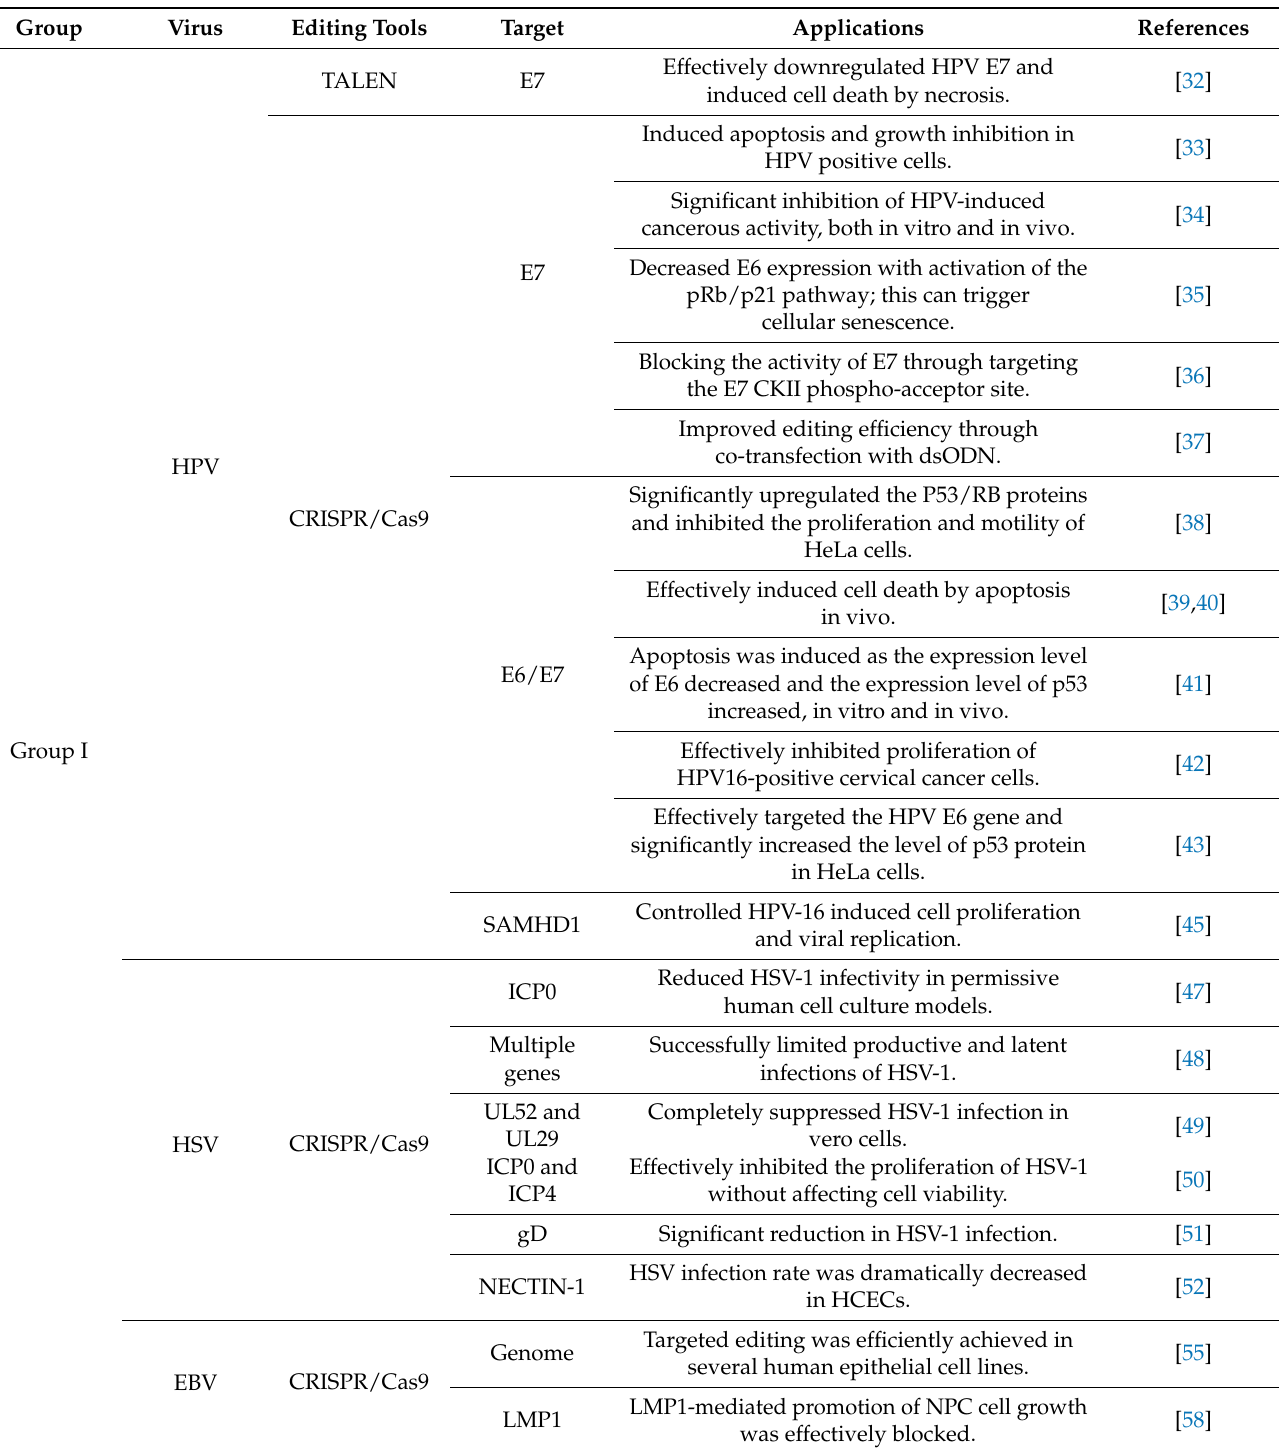
Table 2. Summary data of antiviral genome editing technologies against virus types classified based on the Baltimore classification and used in this